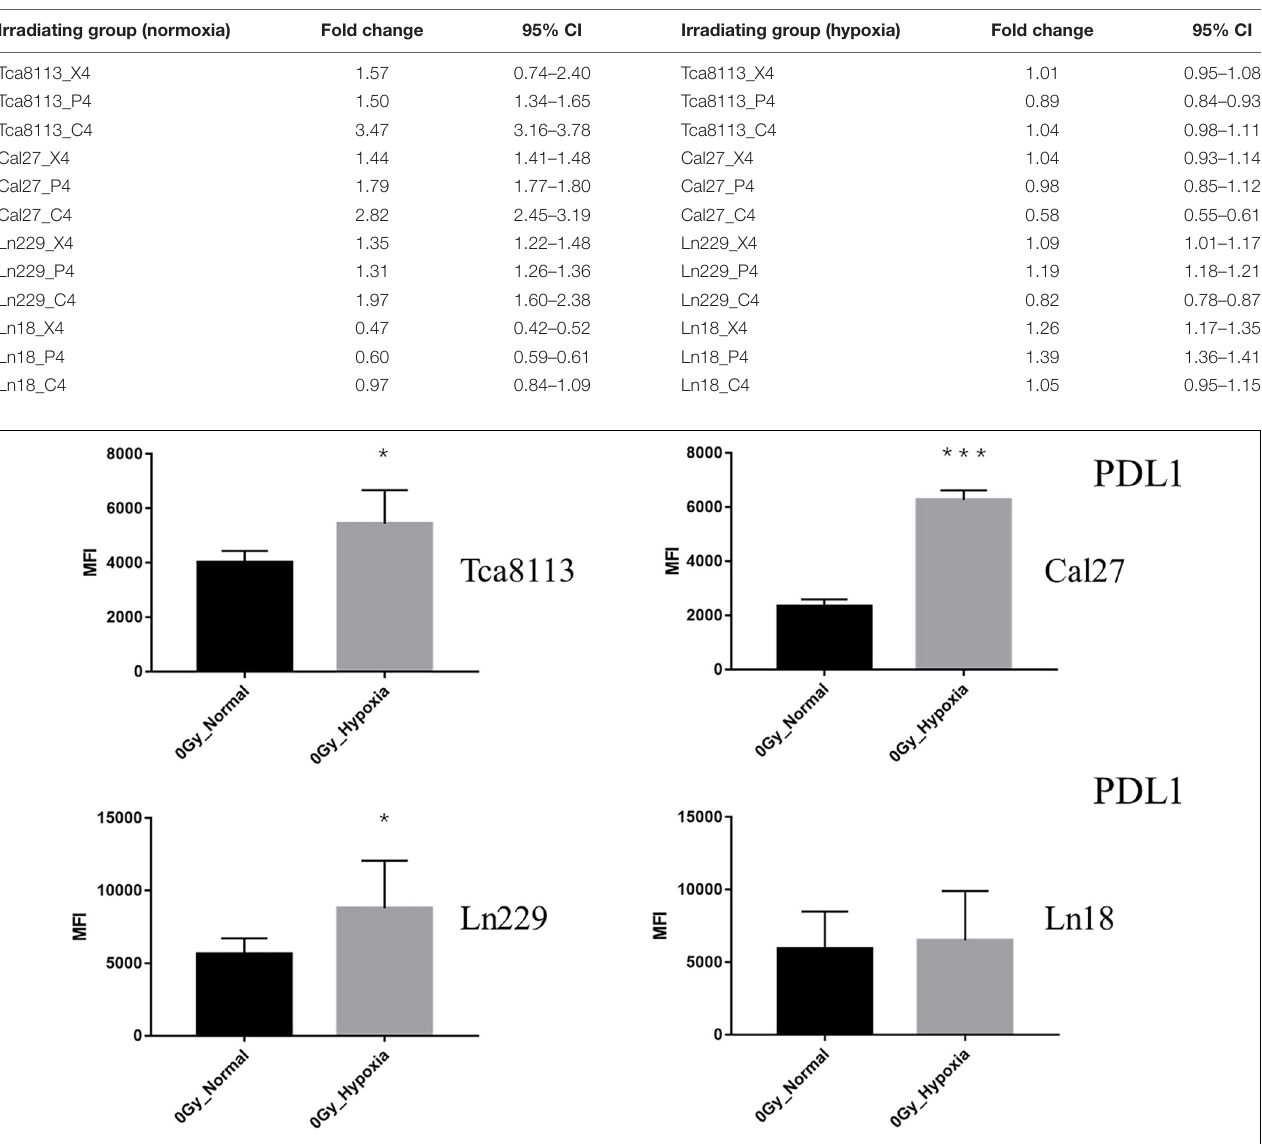
TABLE 4 | The changes in PDL1 expression for each irradiation group under normoxia and hypoxia. Irradiating group (normoxia) Fold change 95% CI Irradiating group (hypoxia) Fold change 95% CI